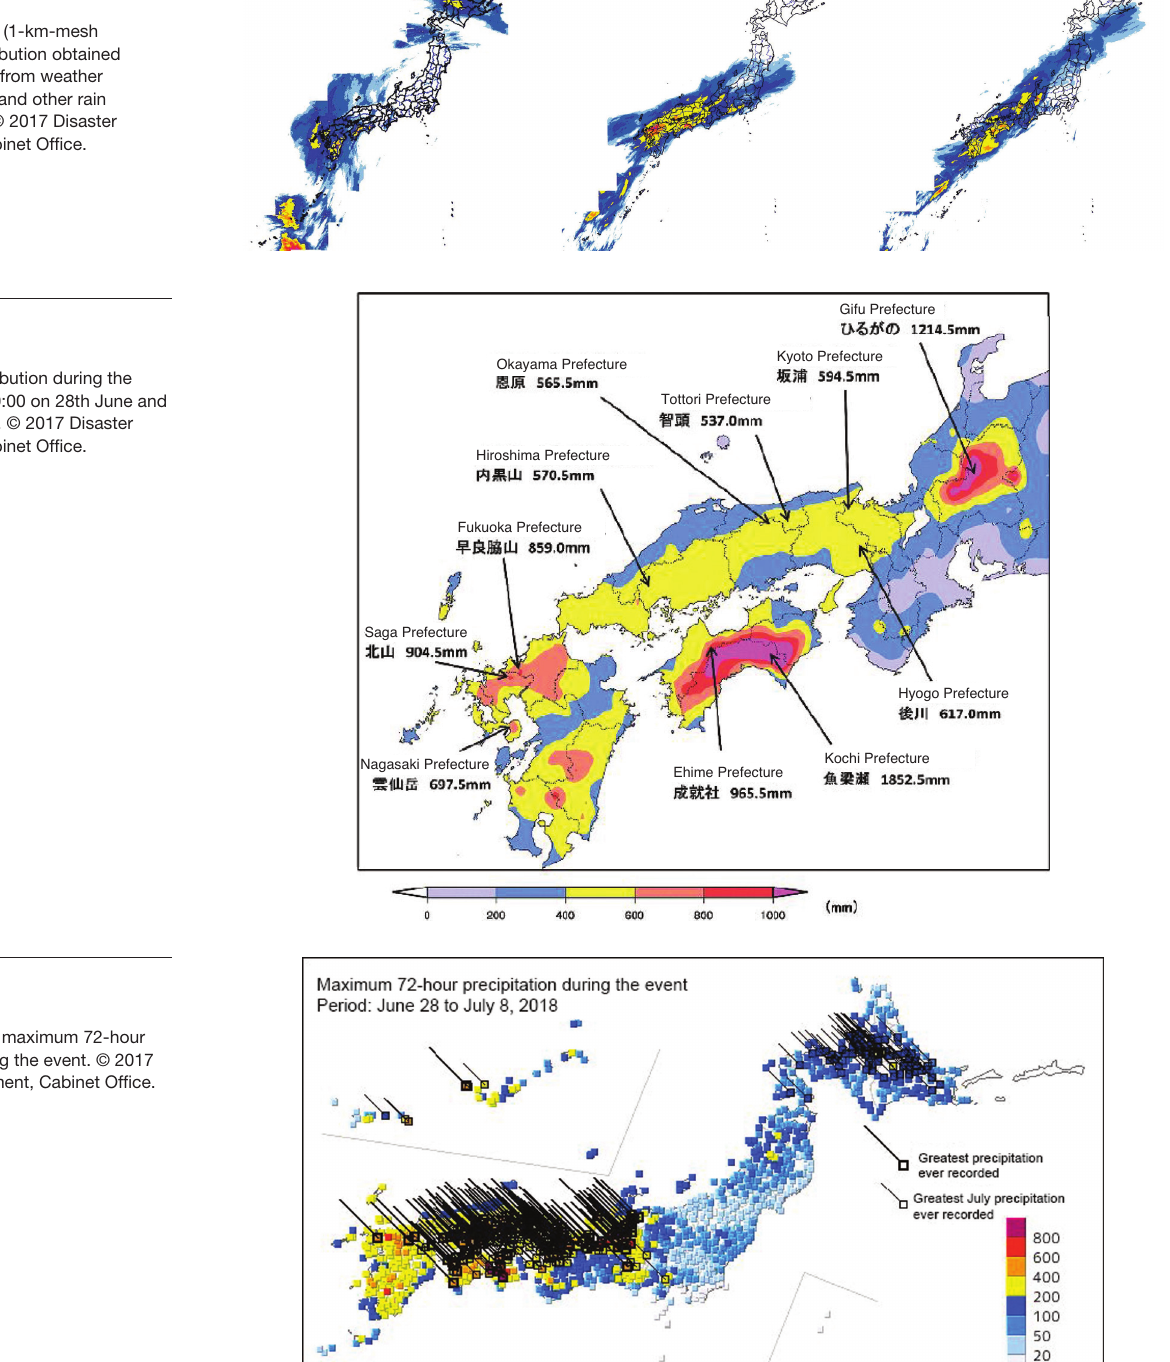
Precipitation distribution during the event (between 00:00 on 28th June and 24:00 on 8th July). © 2017 Disaster Management, Cabinet Office.